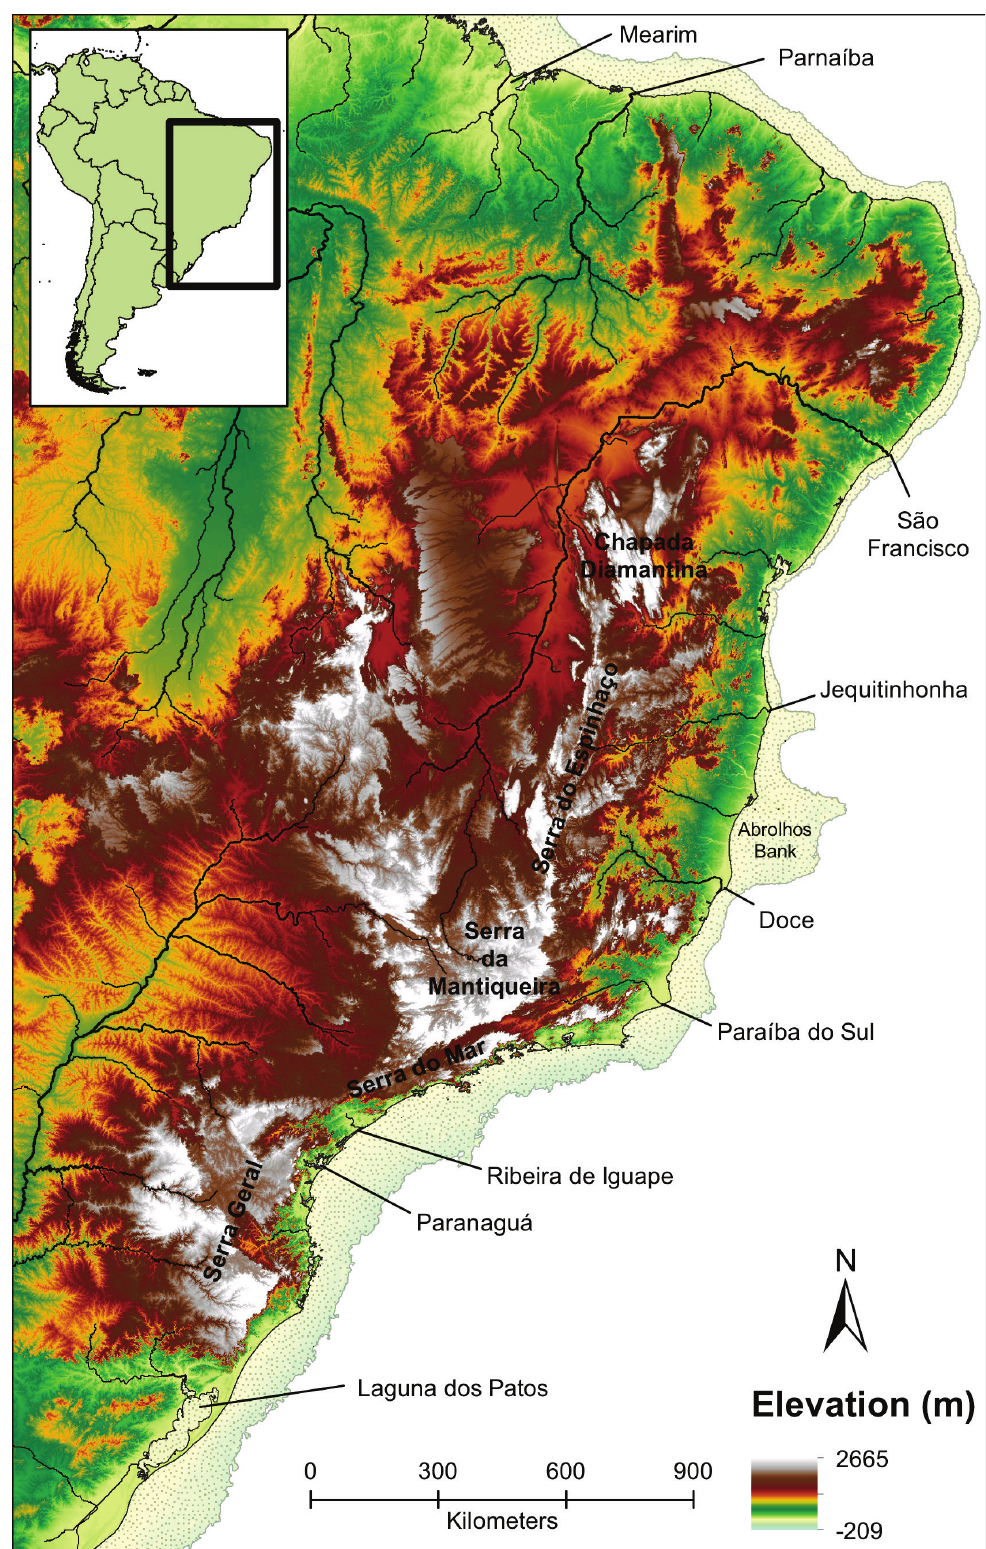
Fig. 1. Map of the Brazilian coast showing main river drainages, bays, lagoons and mountain chains. Elevation and bathy- metric profile for the area highlight the isolation of the coastal basins from inland rivers by mountains, including the Serra do Mar and the Chapada Diamantina in the west. Continental shelf exposed during the Pleistocene is marked with the stippled yellow